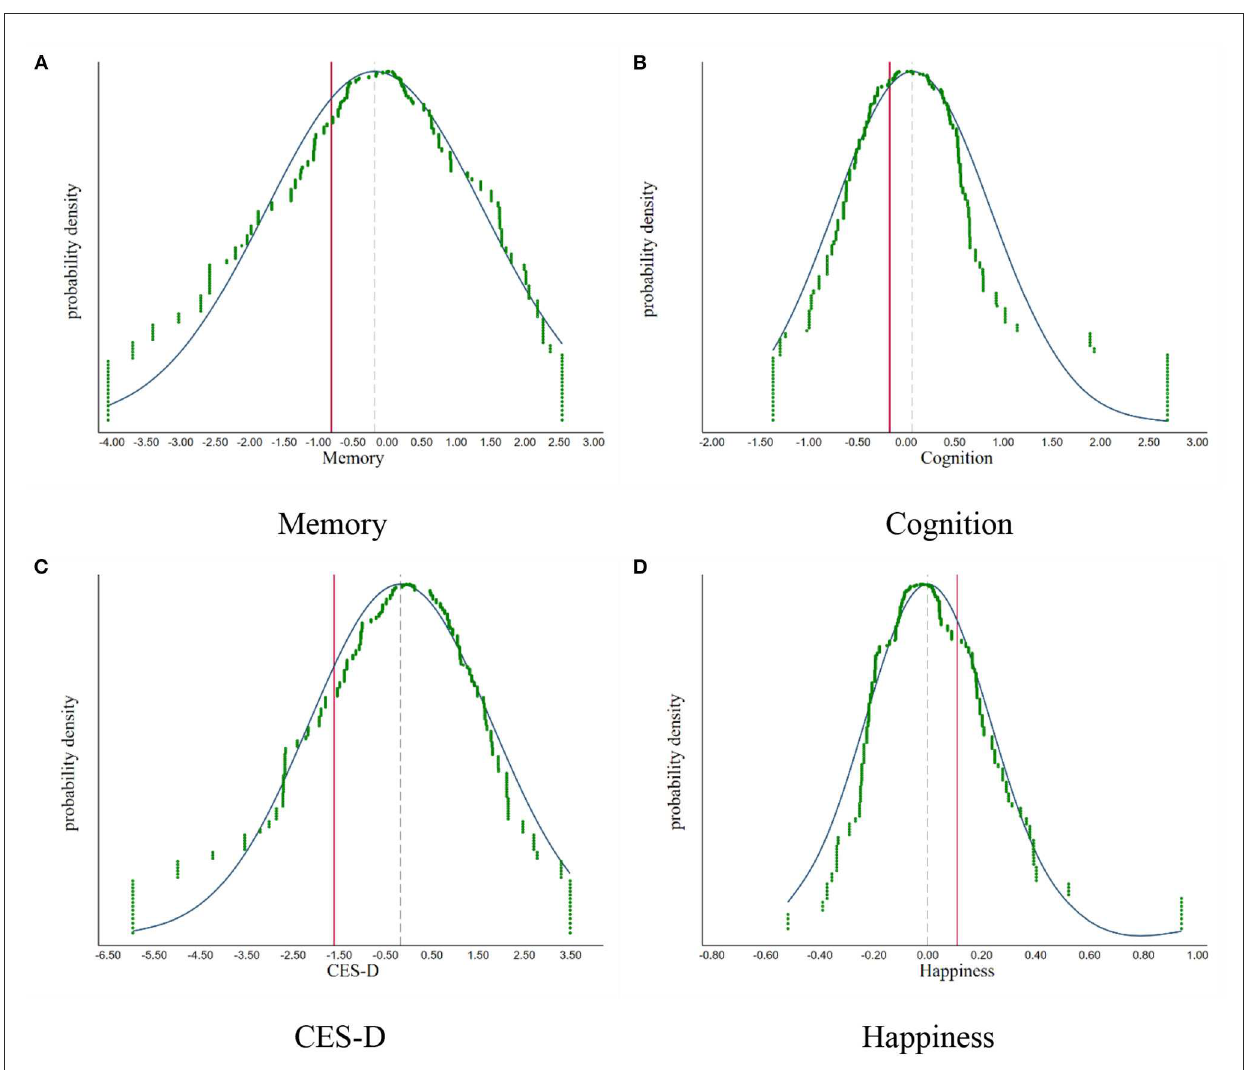
FIGURE3 The placebo test: simulation results of the LTC . (A) Memory. (B) Cognition. (C) CES-D. (D)